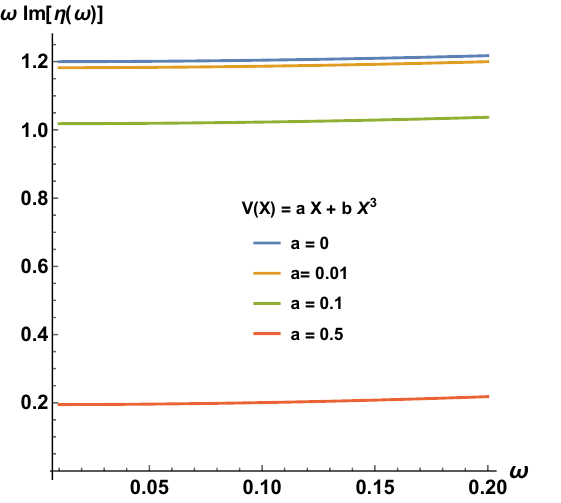
Figure 6 . The imaginary part of the frequency dependent viscosity (4.2) for a potential of the type V ( X ) = a X + b X 3 . We see the presence of a (cid:24) 1 =! pole both in the purely spontaneous and pseudo-spontaneous